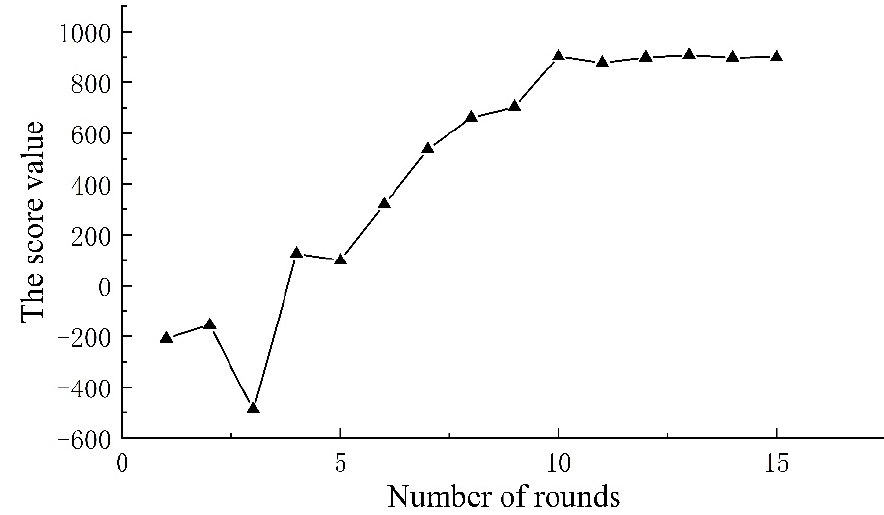
Figure 11. Agent training single-step rewards.